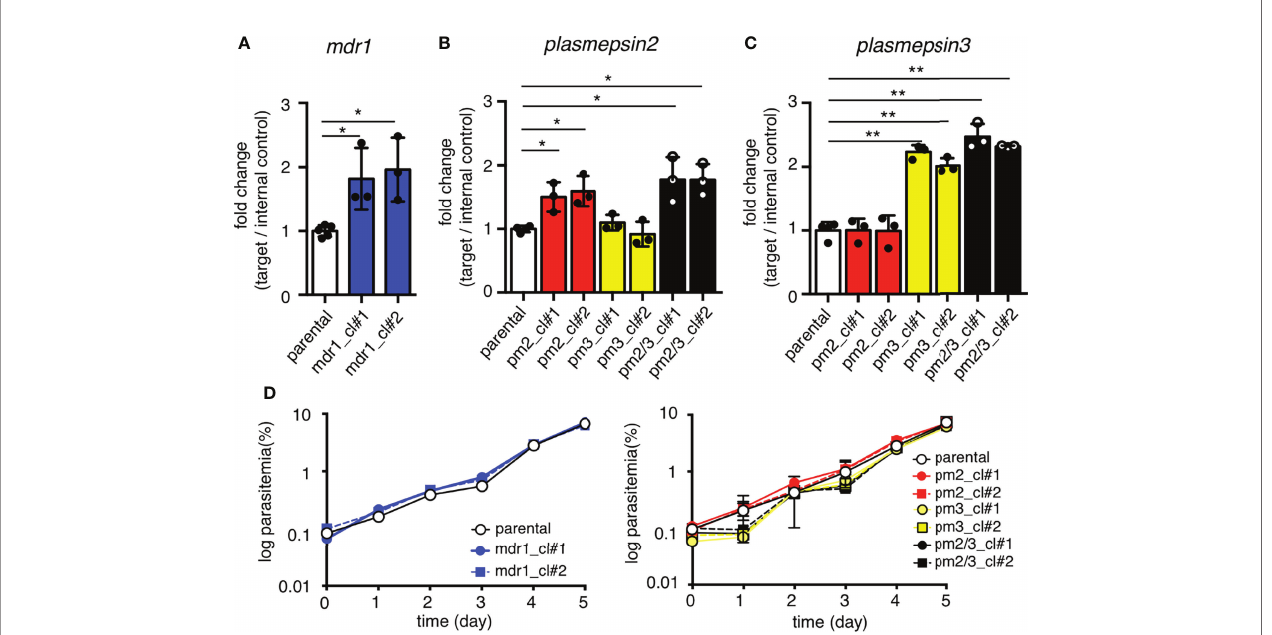
FIGURE 2 | Increased mRNA expression by an additional copy of drug resistance-associated genes. (A) The mRNA expression of mdr1 was measured by quantitative reverse transcription PCR. The two clones of transgenic parasites with integrated mdr1 cassette (blue) had approximately 2-fold increased mRNA expression compared to the parental strain (white). pfcas9-mdr1 clones are labeled mdr1_cl#1 and mdr1_cl#2. (B, C) The mRNA expressions of pm2 or pm3 were measured by quantitative reverse transcription PCR. The pm2 , pm3 , or both-integrated parasites (red, yellow, and black) had approximately 2-fold increased mRNA expression of integrated genes compared to the parental strain. pfcas9-pm2, pfcas9-pm3, and pfcas9-pm2/3 clones are labeled pm2_cl#1 and pm2_cl#2, pm3_cl#1 and pm3_cl#2, and pm2/3_cl#1 and pm2/3_cl#2, respectively. (D) Growth of the transgenic parasites during asexual developmental cycle was comparable to the parental strain (left, mdr1 ; right, pm2 , pm3 , or both). N, n = 3 – 5 ( Supplementary Table 2 ). Signi fi cance was determined using Student ’ s t-tests. *p < 0.01; **p <